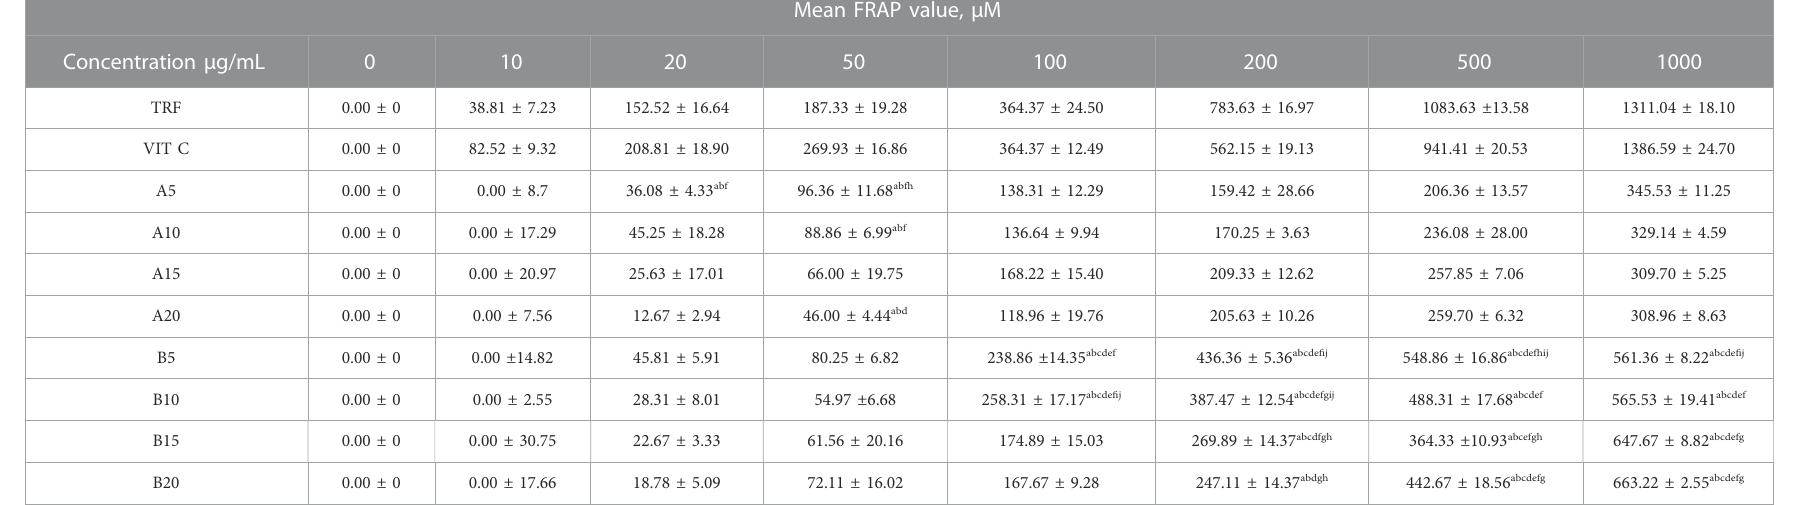
TABLE 4 FRAP activities of soil and soilless ginger and controls. Data presented as mean ± SD (n =